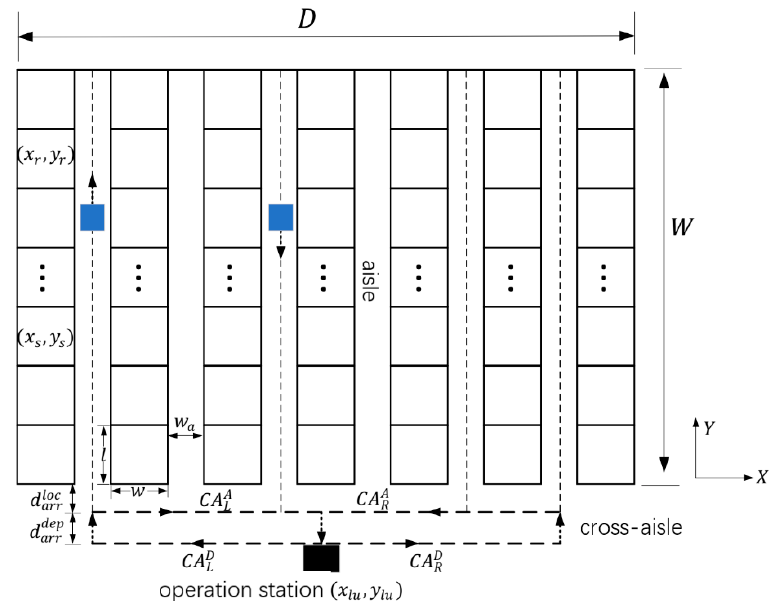
Figure 1. The AGV picking system.